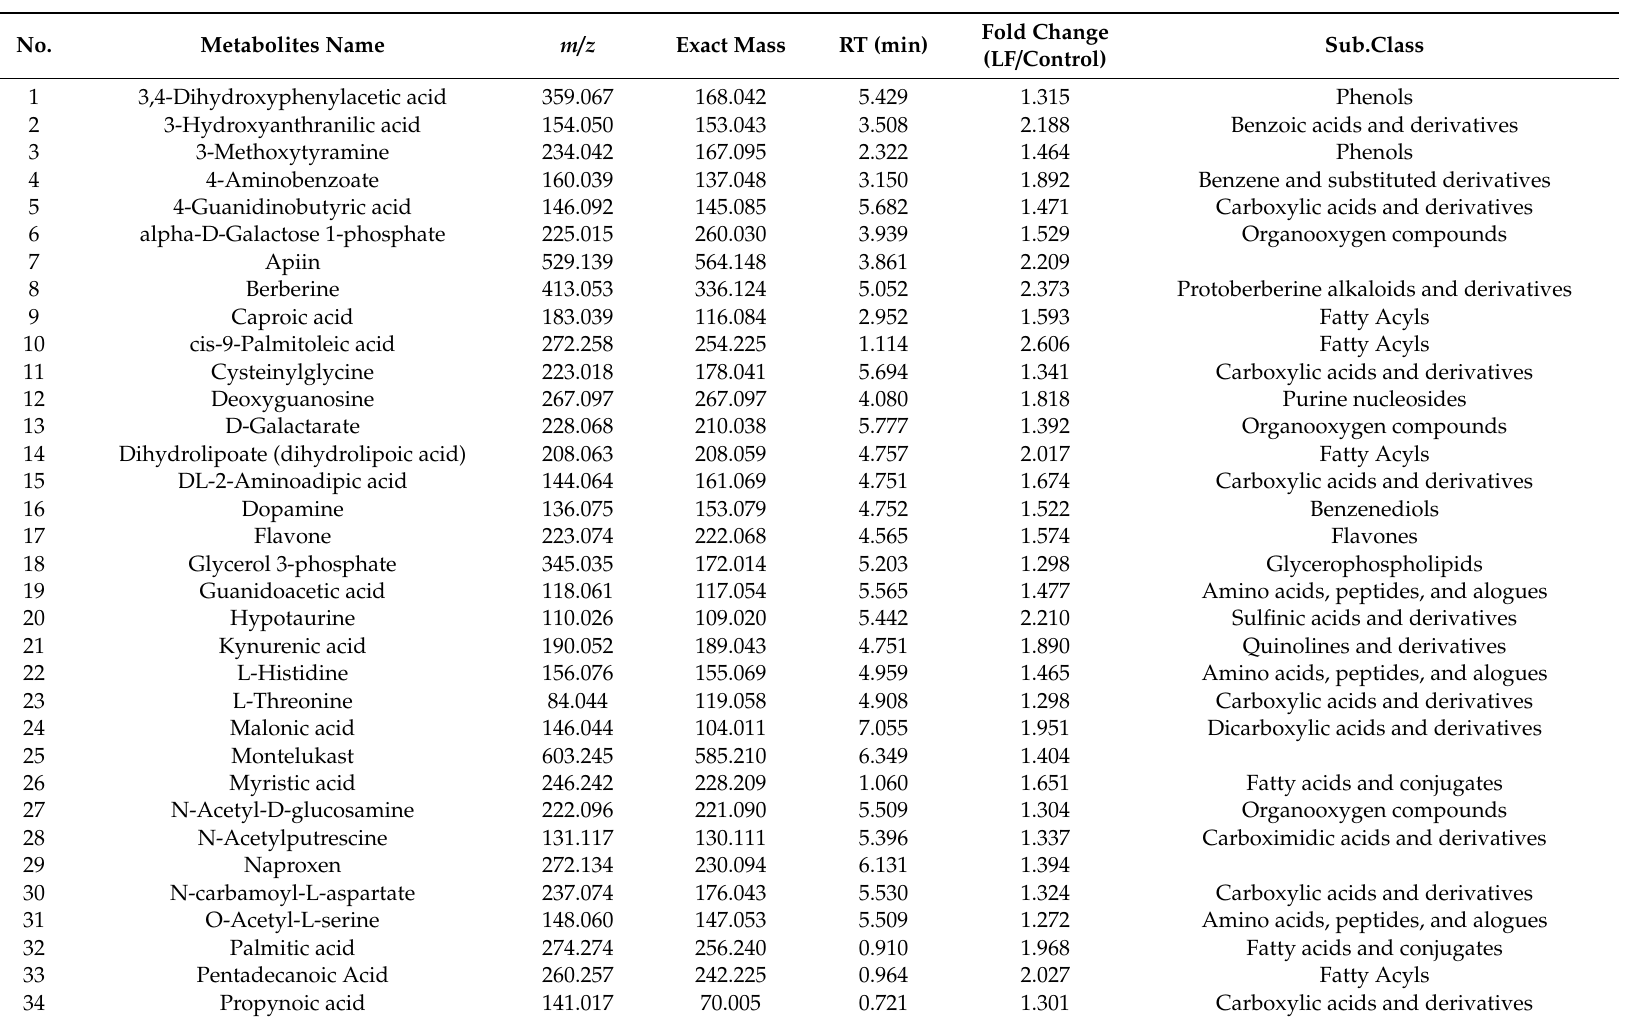
Table 1. Significantly di ff erent metabolites in the urine of SD rats in the control and lactoferrin